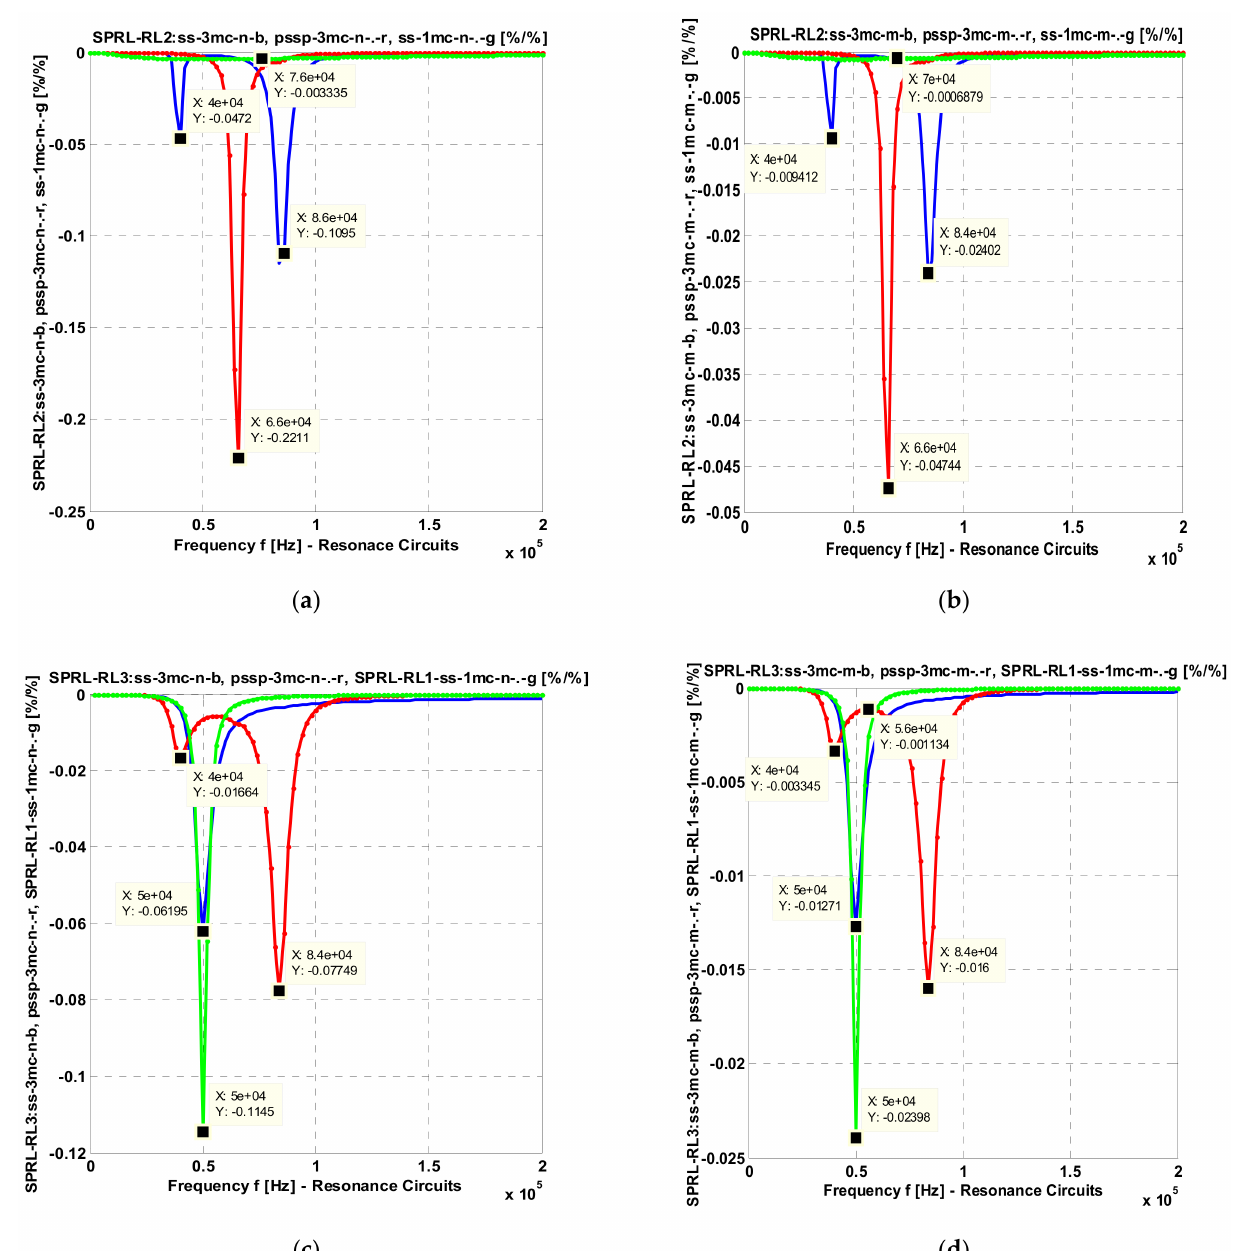
Figure 6. The dependences on frequency of the normalized sensitivity of the active power in relation with the resistances R L 2 and R L 3 of the circuits (coils) 2 and 3: ( a ) S P RL for connections ss-3mc-n, pssp-3mc-n and ss-1mc-n; ( b ) S P RL for connections R L 2 R L 2 ss-3mc-m, pssp-3mc-m and ss-1mc-m, when the values of the resistances R L 2 and R L 3 , for connections ss-3mc and pssp- 3mc-m, and the values of the resistances R L 1 and R L 2 for connection ss-1mc, respectively, are five times reduced; ( c ) S P RL for R L 3 connections ss-3mc-n, pssp-3mc-n and ss-1mc-n; ( d ) S P RL for connections ss-3mc-m, pssp-3mc-m and ss-1mc-m when the R L 3 values of the resistances R L 2 and R L 3 , for connections ss-3mc and pssp-3mc-m, and for the values of the resistances R L 1 and R L 2 for connection ss-1mc, respectively, are five times